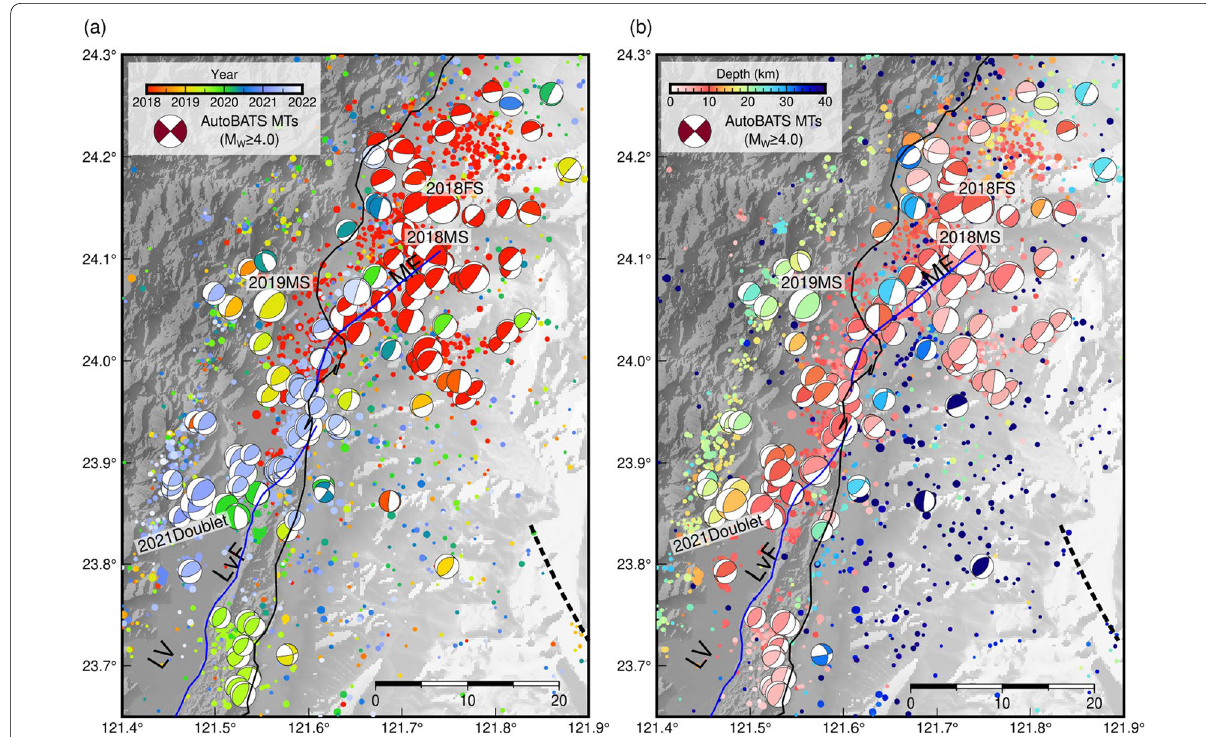
Fig. 2 2018–2022 Hualien earthquake sequence colored in accordance with a temporal evolution and b focal depth, where focal mechanisms (M W 4.0) and background seismicity were obtained from AutoBATS MT and CWB catalog: a colors represent interval between earthquakes (in ≥ years) with respect to M W‑ 5.9 2018 foreshock; b colors represent focal depth reported by CWB catalog (note 2018FS: Feb. 04, 2018 foreshock (M W 6.0); 2018MS: Feb. 06, 2018 mainshock (M W 6.4); 2019MS: Apr. 18, 2019 mainshock (M W 6.2); 2021 Doublet: the Apr. 18, 2021 earthquakes (M W 5.9 &